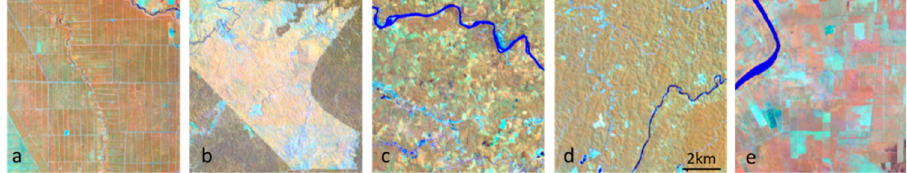
form one large oil palm landscape. (e) Sometimes smallholder plantations owned by wealthy individuals extend several hundreds of hectares and resemble the linear structures of industrial plantations, although with less